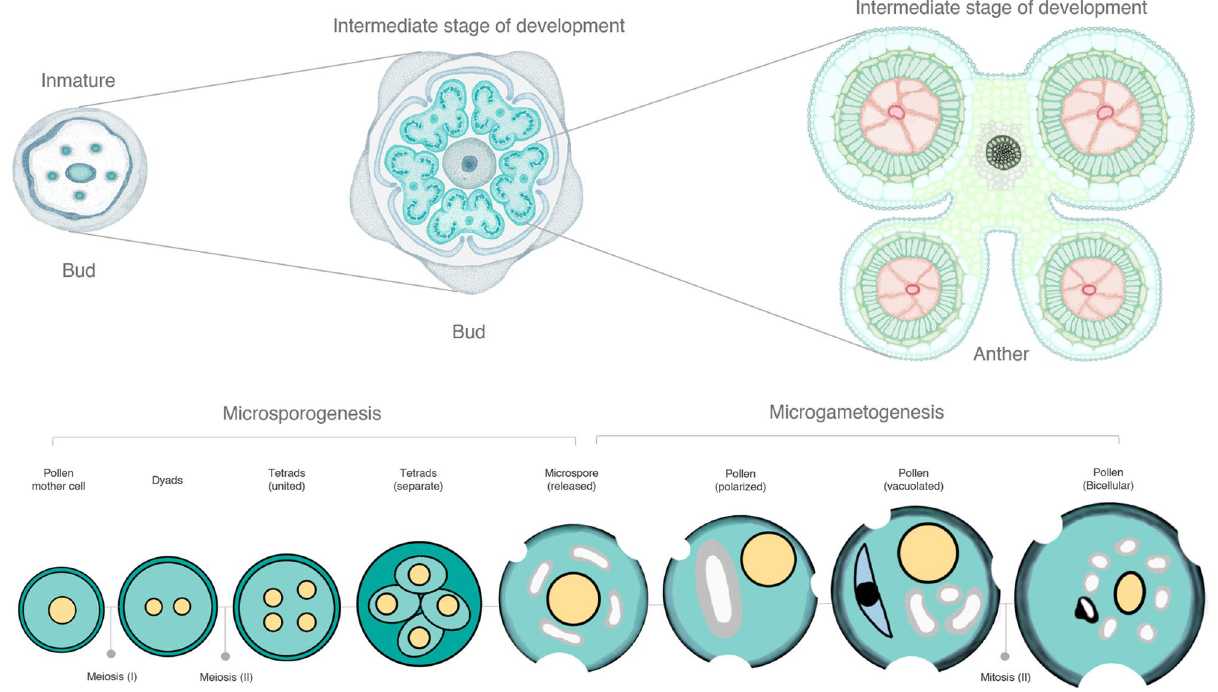
Figure 6. Schematic view of cytological events associated with development of bud, anther y pollen in diploid yellow potato. Scheme devised and recreated by the authors with images illustrated by Camila Reyes and Angie